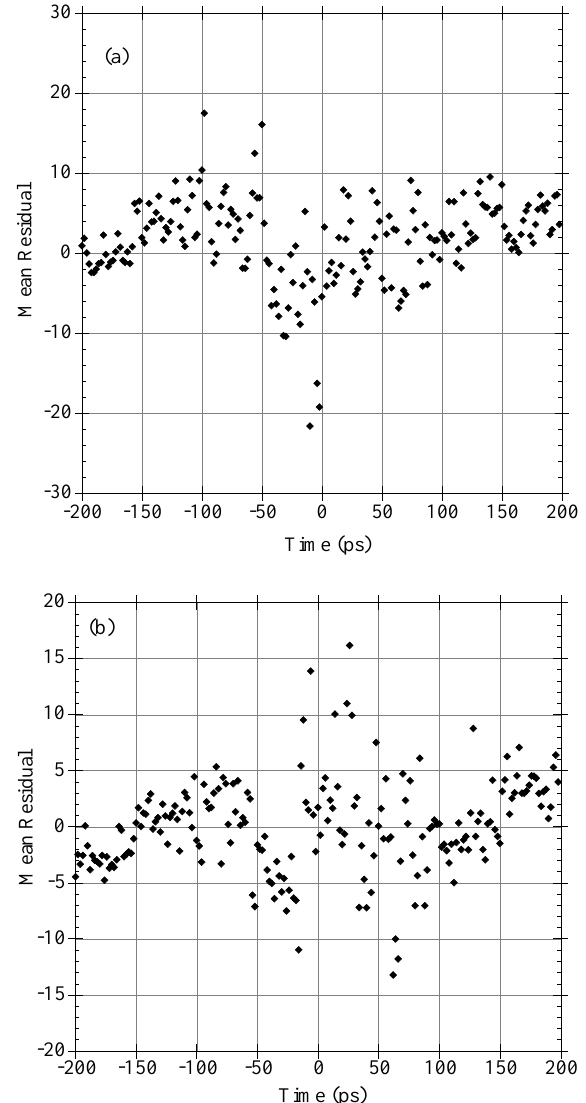
FIG. 27. The mean residual with the instability (a) present and (b) not